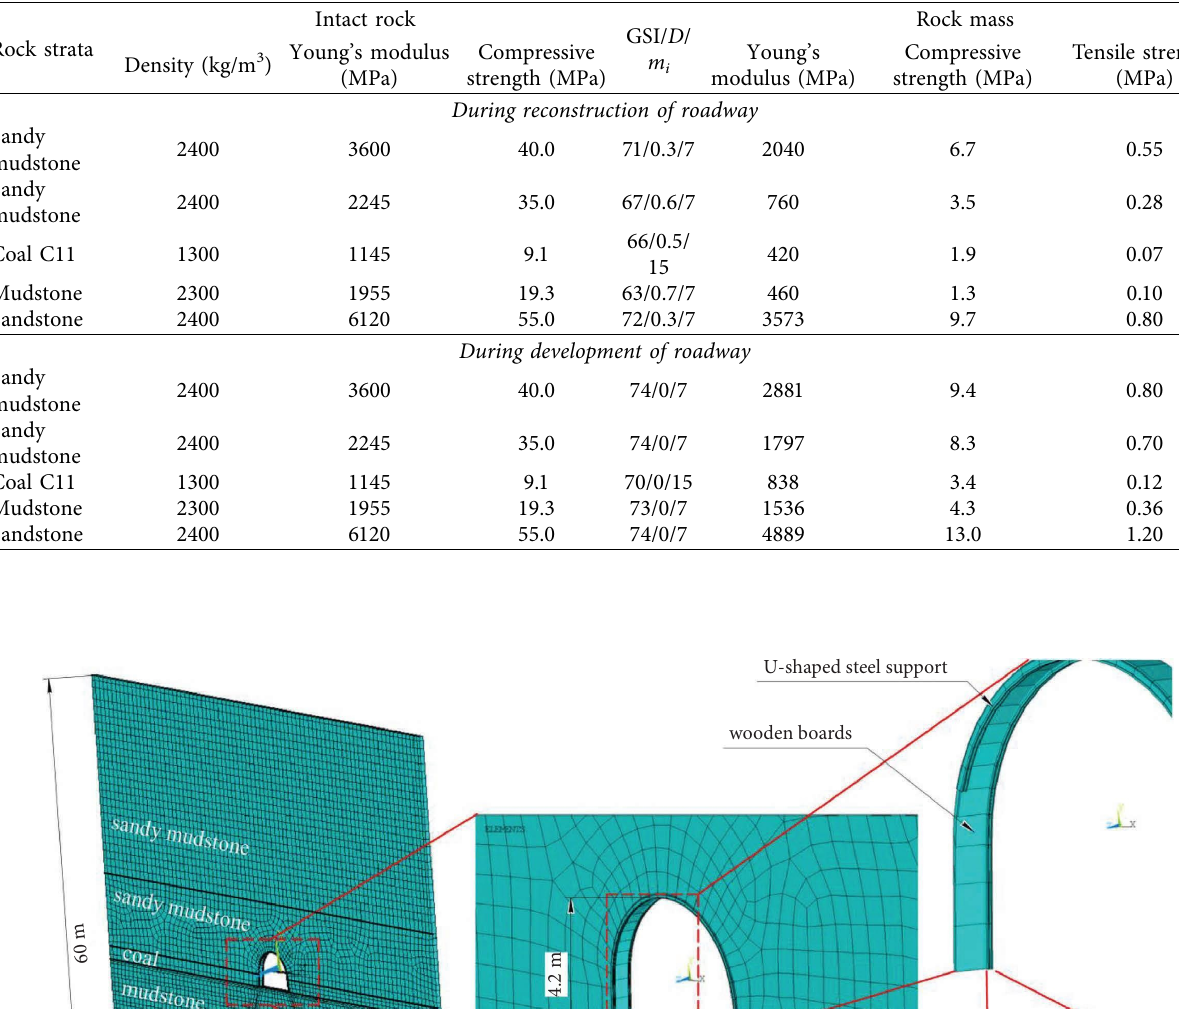
Table 1: Intact rock properties and calculated rock mass